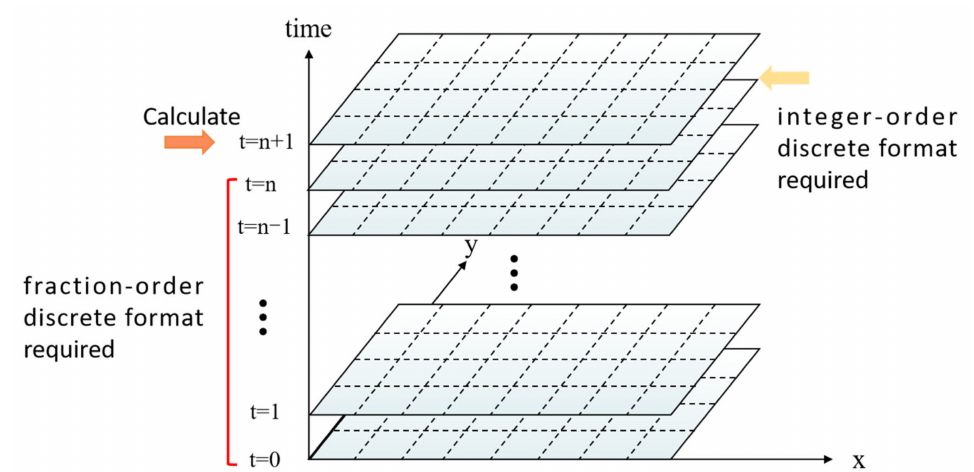
Figure 3. Fractional‑order versus integer‑order temporal step advance calculation.